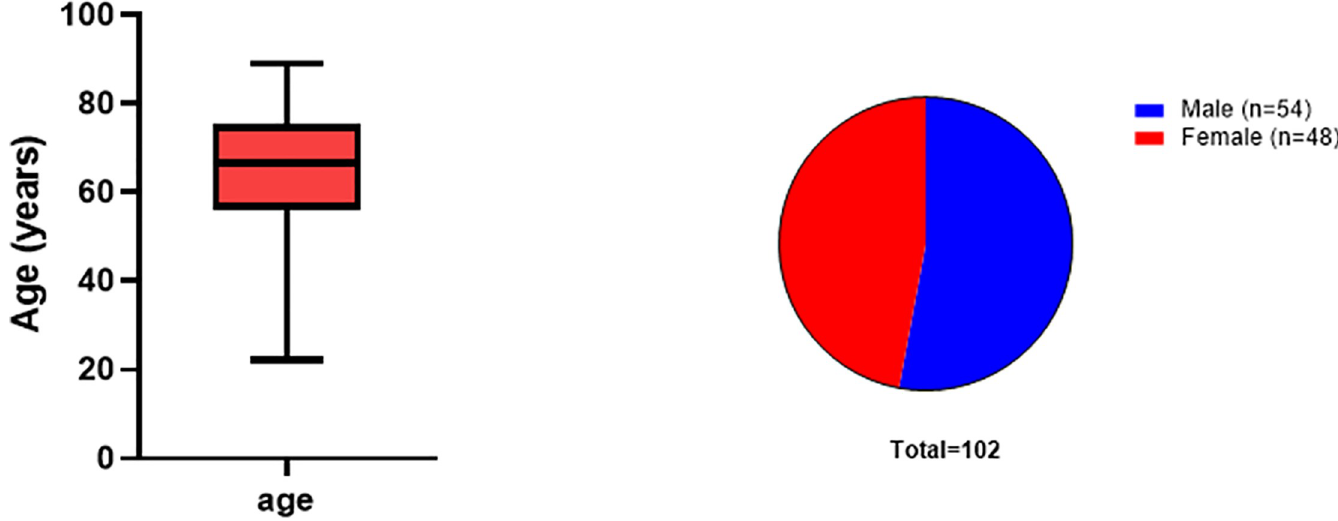
Fig 1. Patient demographics including age (A) and sex (B).